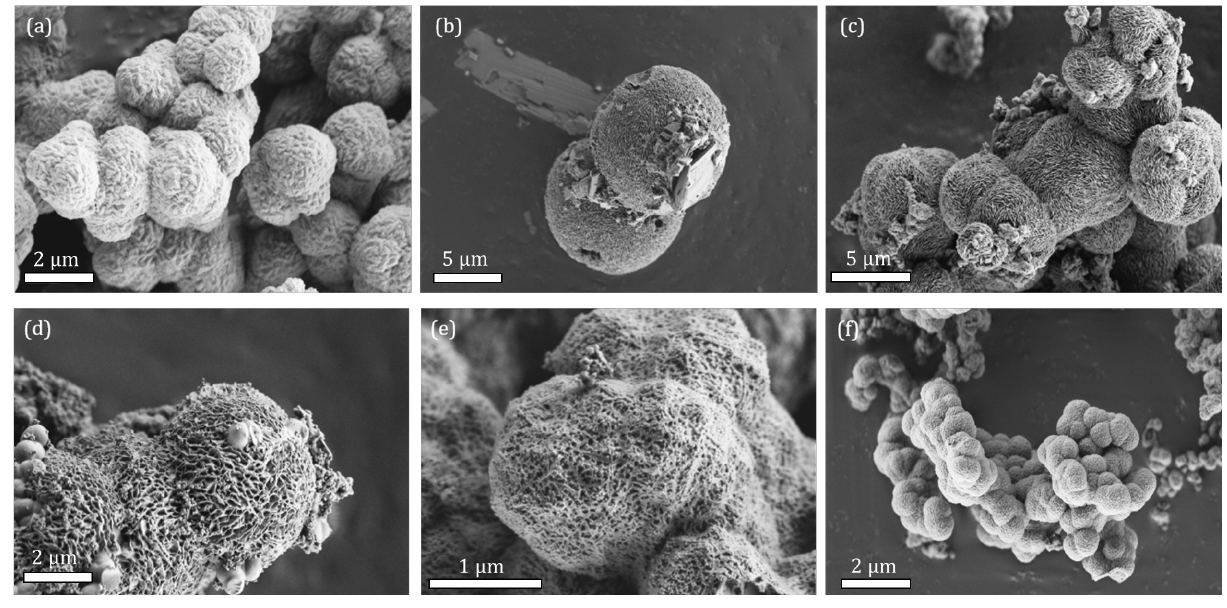
Figure 2. SEM micrographs of bioNICS1 with increasing amount of dichloroacetic acid as an additive. ( a ) 1.5 mol ; ( b ) 2 mol ; ( c ) 3 mol ; ( d ) 4 mol ; ( e ) 6 mol ; ( f ) pristine bioNICS-1 with no additive.